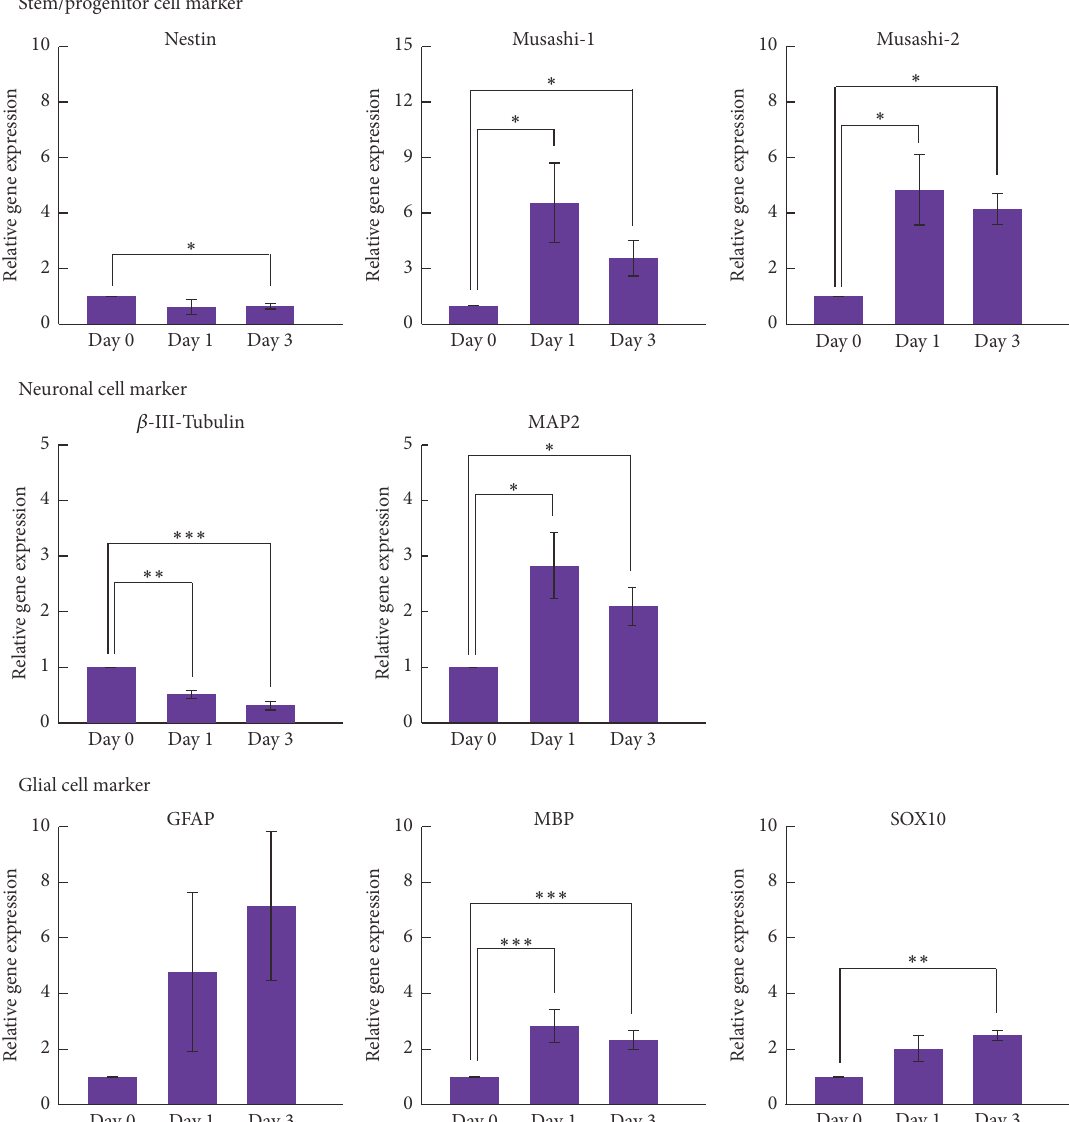
Figure 7: Gene expression of neural markers in hDFCs following two-step neuronal induction. Gene expression was examined in hDFCs during neuronal differentiation after the neurosphere formation. Values represent means ± SD (𝑛 = 3) . ∗ 𝑝 < 0.05 , ∗∗ 𝑝 < 0.01 , ∗∗∗ 𝑝 < 0.005 .